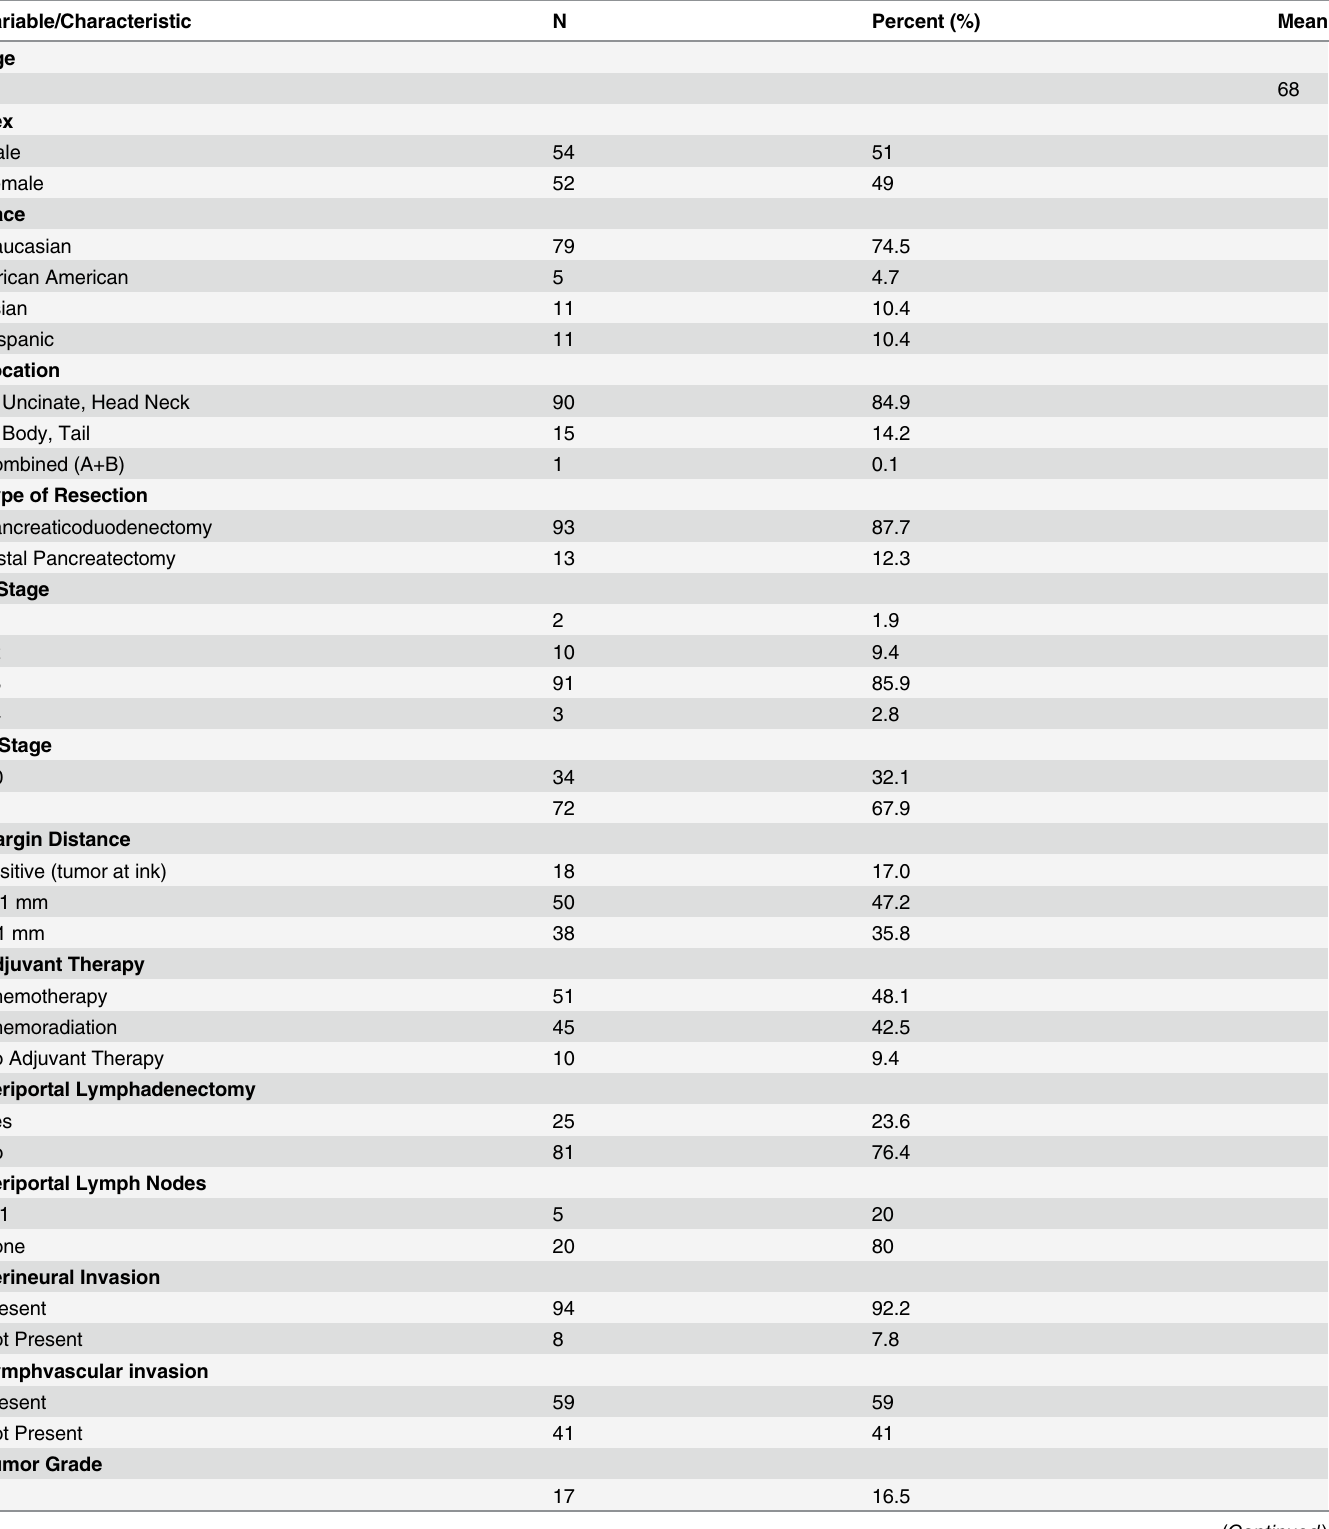
Table 1. Patient Disease Specific